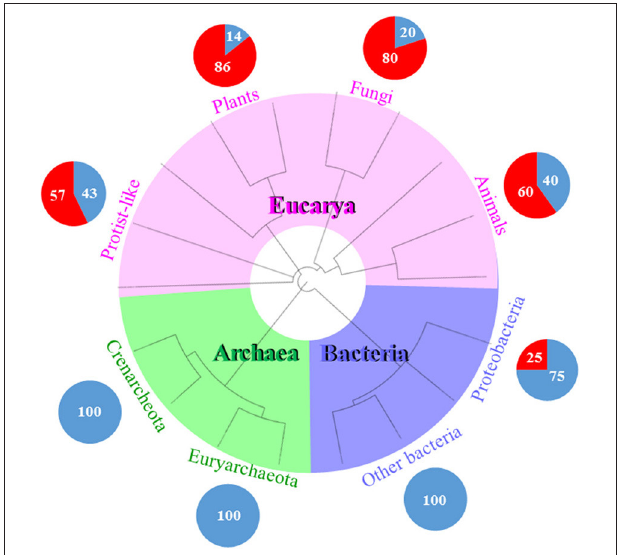
FIGURE 3 | RNA viruses mostly infect eukaryotes. This schematic tree represents the three domains of life (Bacteria in purple, Archaea in green, and Eucarya in pink). Each pie chart represents the percentage of DNA or RNA viral families infecting each domain. For example, there are only two RNA and six DNA viral families representing the 25 and 75%, respectively, which infect Proteobacteria and no other bacteria. Proteobacteria is a phyla which is phylogenetically and physiologically related to eukaryotes. It seems that the evolutionary history of RNA viruses is linked to the phylogeny of the recent eukaryotes. The phylogenetic tree was generated and visualized using iTOL (2). The circular tree was constructed following the online instructions based on Letunic and Bork